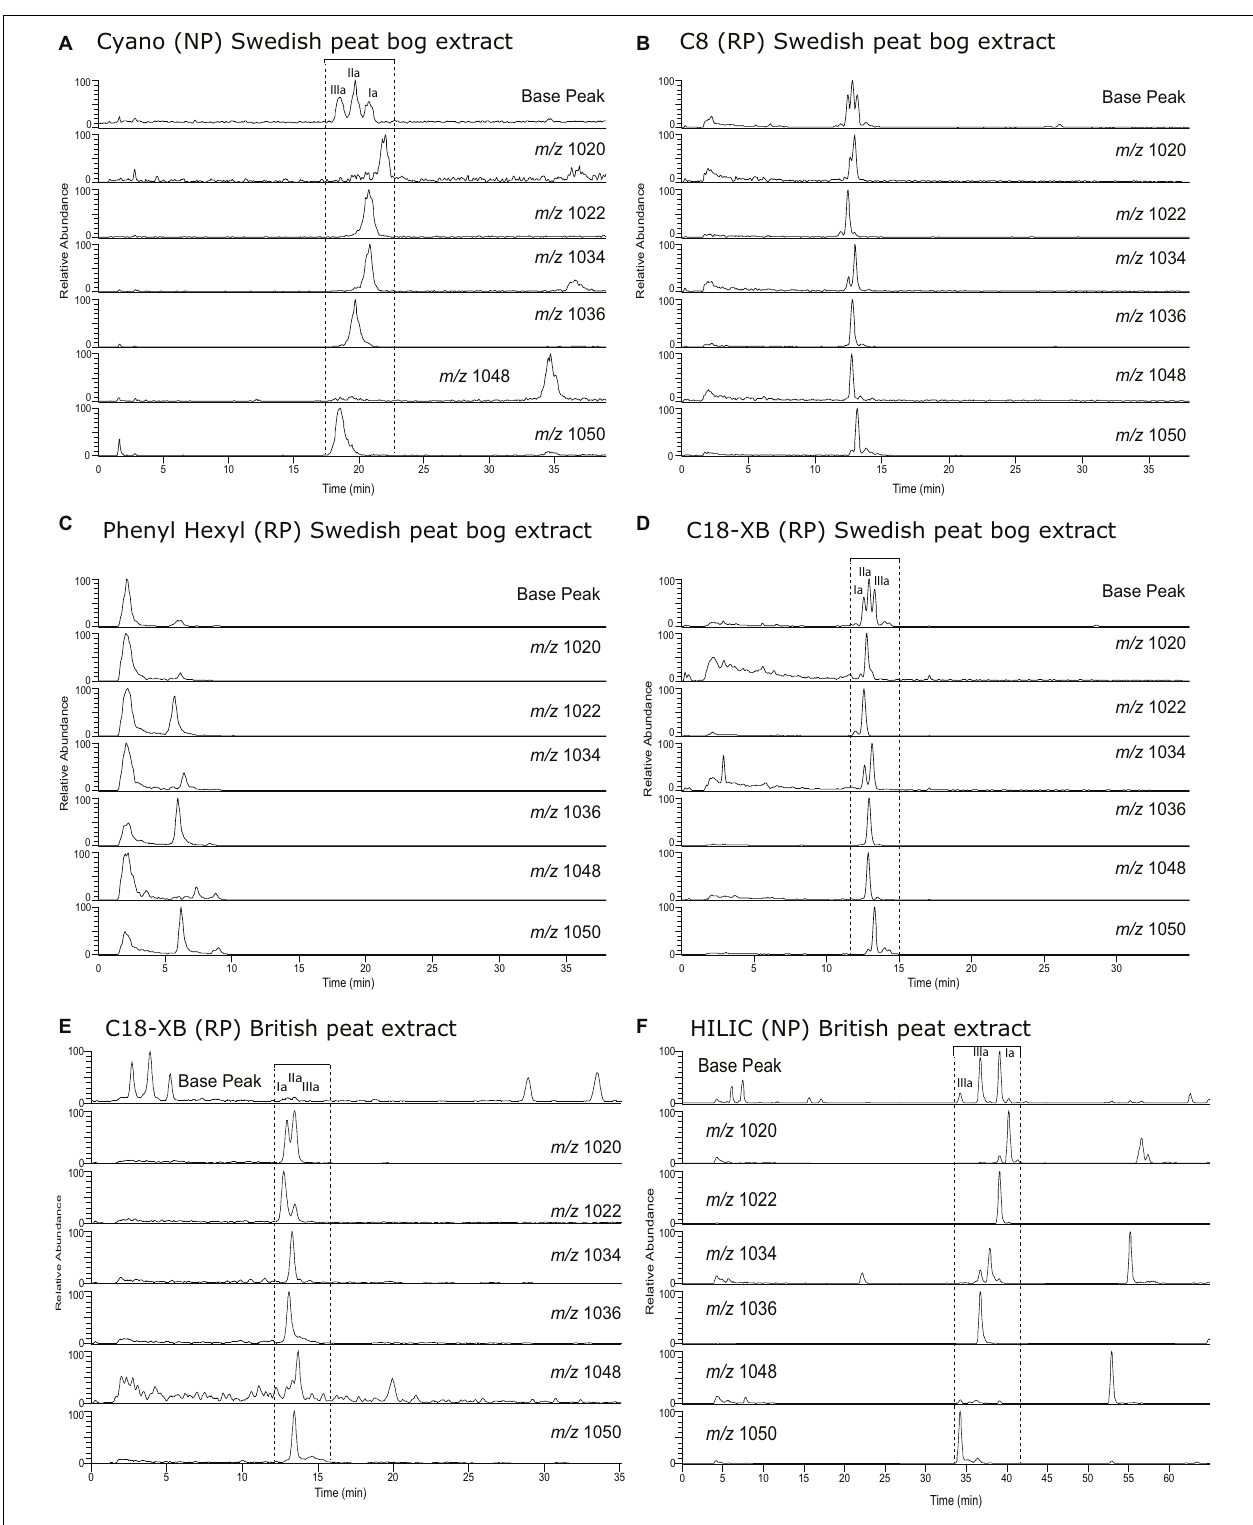
Frontiers in Marine Science |